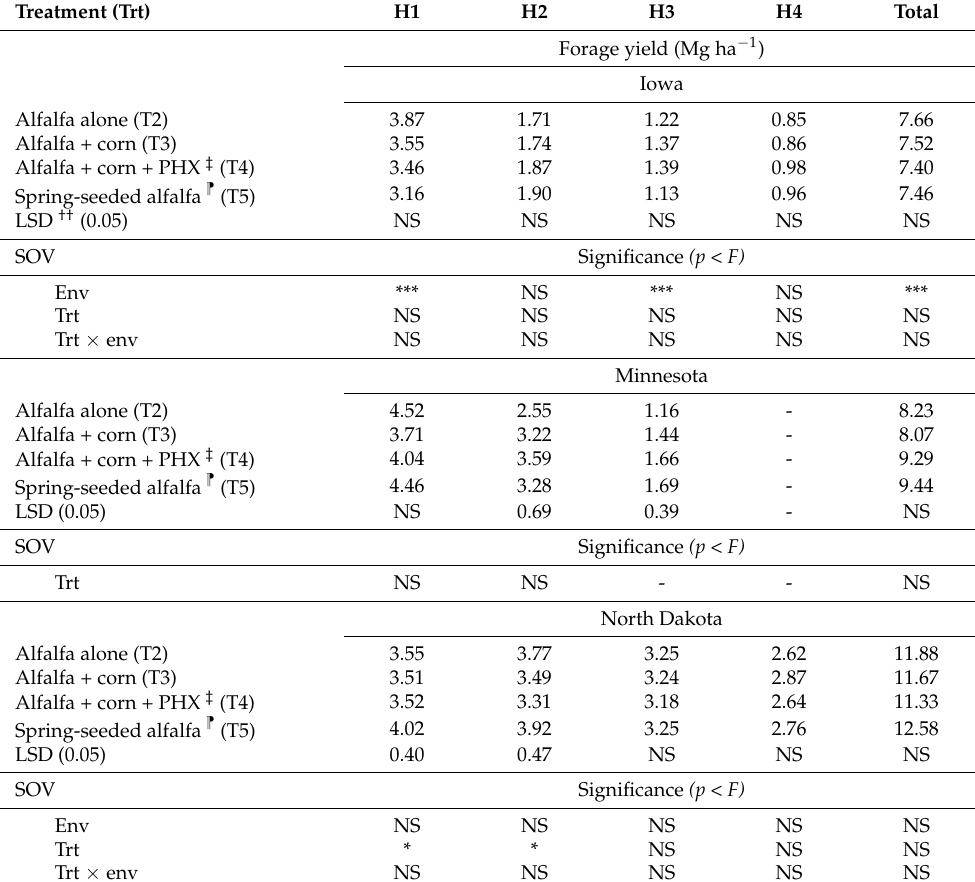
Table 8. Alfalfa forage yield for four harvests (H1, H2, H3, and H4) and total in the second production year averaged across environments (Env) within a same state † . Table 7. Alfalfa forage yield in the first production year for four harvests (H1, H2, H3, and H4), and total seasonal averaged across environments (Env) within a same state † and significance of effects (source of variation, SOV) in the model. Treatment